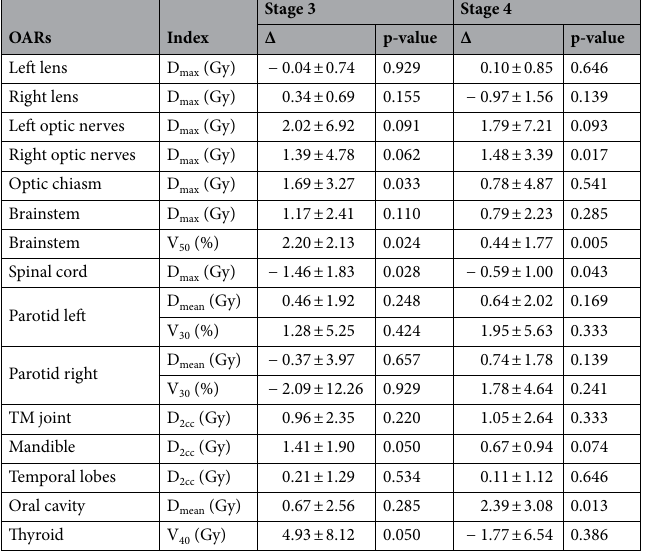
Table 6. Differences in dosimetric parameters between manual and automatic VMAT for the OARs stratified by overall stage (mean ±